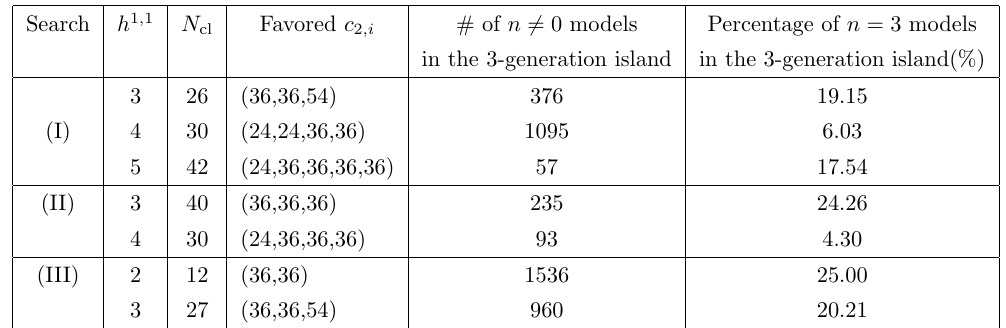
Table 4 . Number of clusters N cl , # of n 6 = 0 models and percentage of n = 3 models in the 3-generation island. Favored c 2 ;i in the 3-generation island is